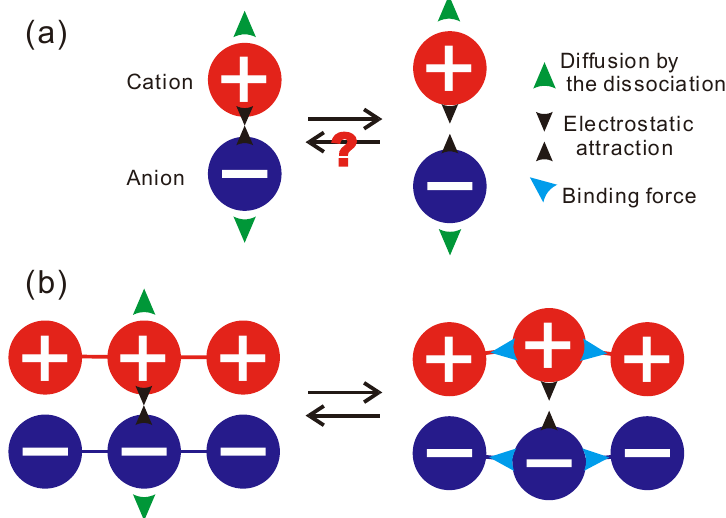
Figure 4. Schematic illustrations of bindings between cations and anions. ( a ) bound cation and anion will dissociate, and it is unknown if the binding between the dissociated ions would occur again; ( b ) the bond between cationic and anionic polymers will break at one site, and the bond between the sites will be formed again because other bonds are not broken at the same time.